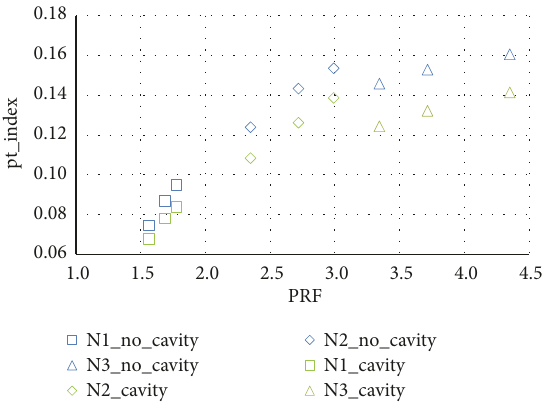
Figure 20: pt index vs PRF comparison, partial shroud admission.